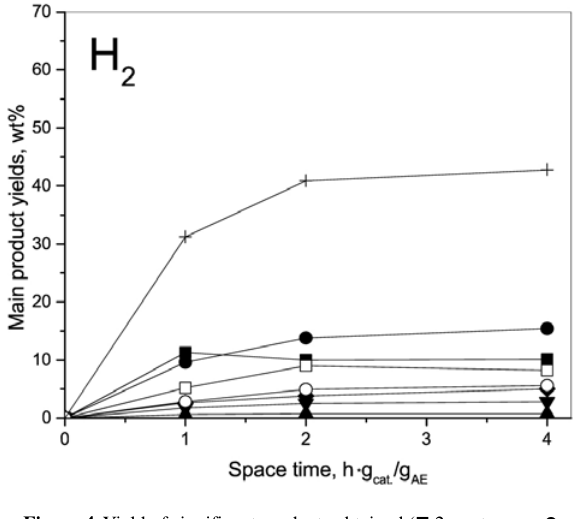
Figure 4. Yield of significant products obtained ( (cid:2) 2-pentanone, (cid:4) 4-heptanone, (cid:3) 2-pentanol, (cid:5) 4-heptanol, (cid:3) 2-heptanone, (cid:2) 4-nonanone, (cid:6) gas by-products, + sum of main alkylates) over 5Pd,20CsOH/AC catalyst in hydrogen as a function of space time. The reaction was carried out at 21 bar total pressure and 300